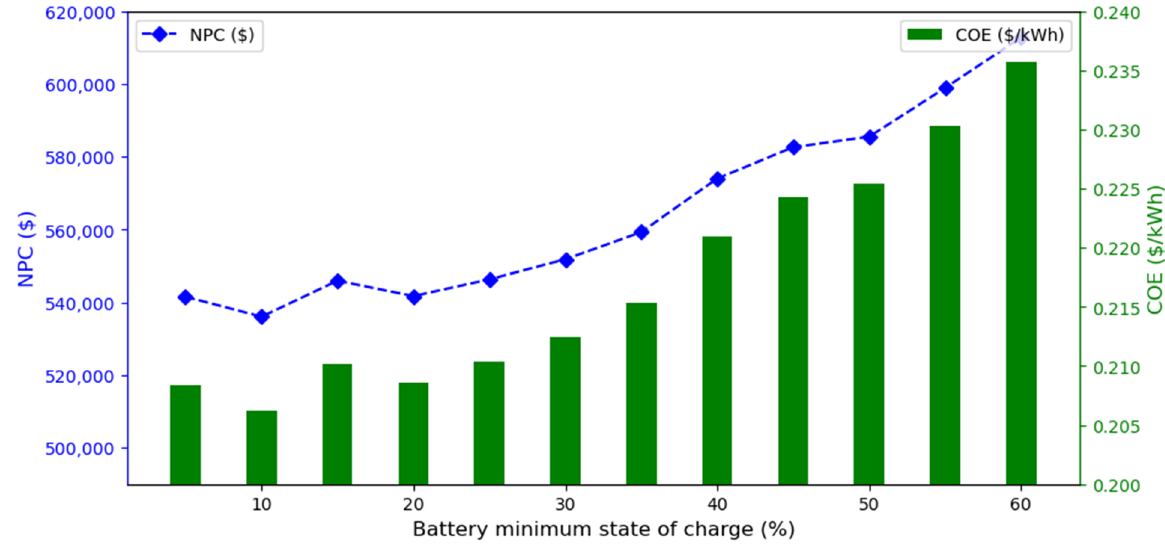
Figure 12. Effect of varying the battery SOC minimum on the NPC and the COE of the optimal charging system.